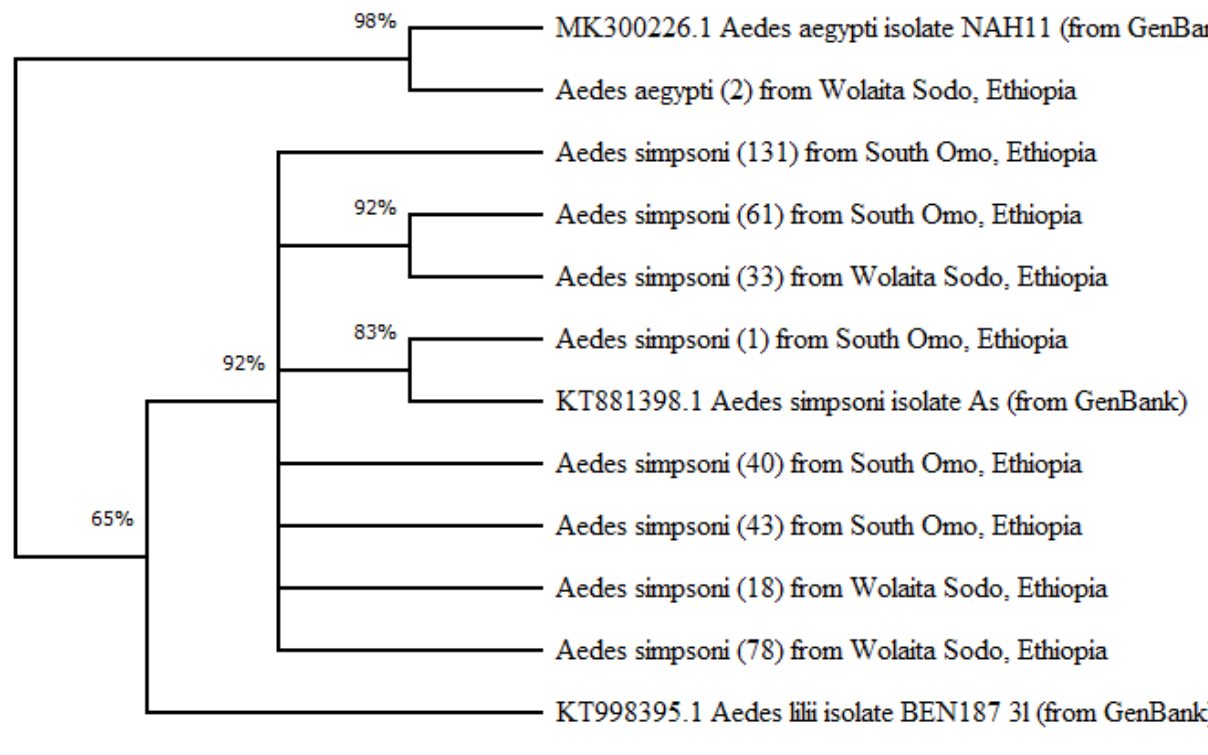
Figure 5. Evolutionary analysis by the evolutionary likelihood method and the Tamura-Nei model: a phylogenetic tree. The evolutionary history was inferred using the neighbor-joining method [25]. The optimal tree with the sum of branch length = 0.17579417 is shown. The percentage of replicate trees in which the associated taxa clustered together in the bootstrap test (500 replicates) is shown next to the branches. The evolutionary distances were computed using the Maximum Composite Likelihood method [20] and are in the units of the number of base substitutions per site. The differences in the composition bias among sequences were considered in evolutionary comparisons. The proportion of sites where at least one unambiguous base is present in at least one sequence for each descendant clade is shown next to each internal node in the tree. This analysis involved 12 nucleotide sequences. All ambiguous positions were removed for each sequence pair (pairwise deletion